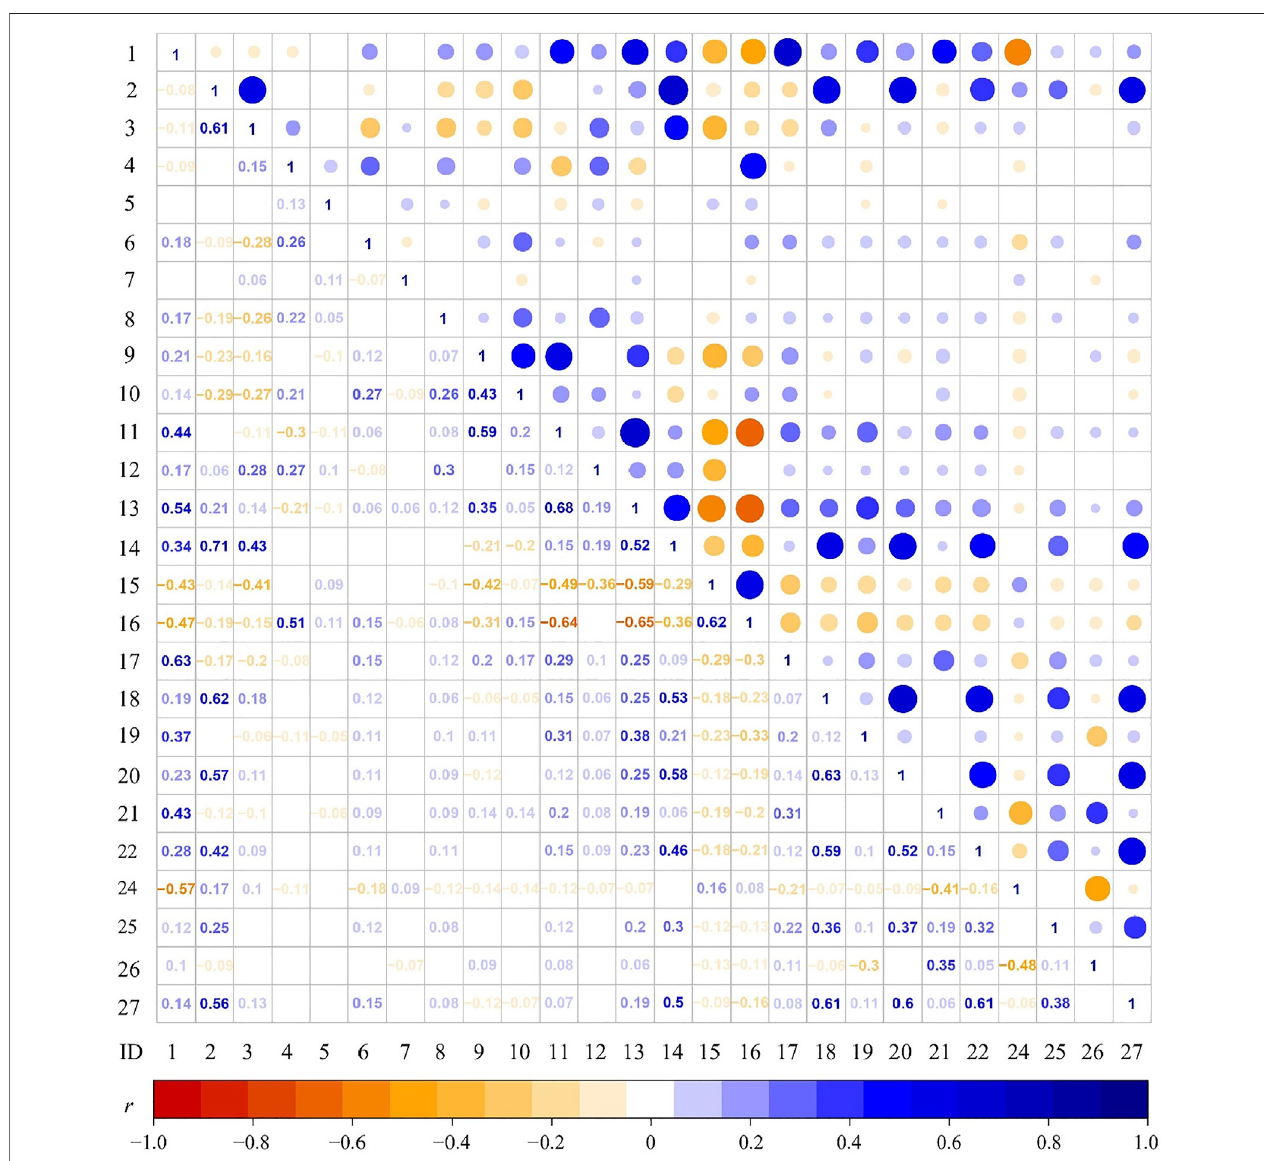
FIGURE 6 | Pearson ’ s correlation coef fi cient matrix of the continuous covariates used in this research. ID number corresponds to the acronym of covariates in Table3 .TherangeofPearson ’ scorrelationcoef fi cients r liesbetween − 1and1,andthelargermodulus| r |valuestandsformoresigni fi cantcollinearity. r =0indicatesno correlation. r > 0 demonstrates that there is a positive correlation that one increases with the increase of other covariates. Conversely, r < 0 means a minus linear dependency.